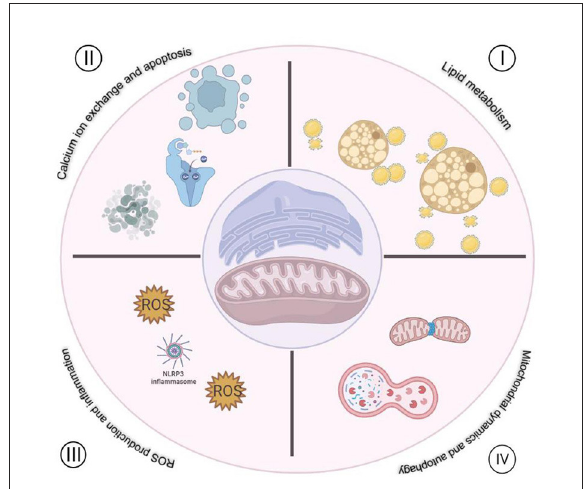
FIGURE1 Functions of MAMs in cardiovascular disease. I. Regulation of lipid metabolism. II. Regulation of Ca 2 + exchange between mitochondria and ER. III. Regulation of ROS production and inflammation. IV. Regulation mitochondria dynamics and